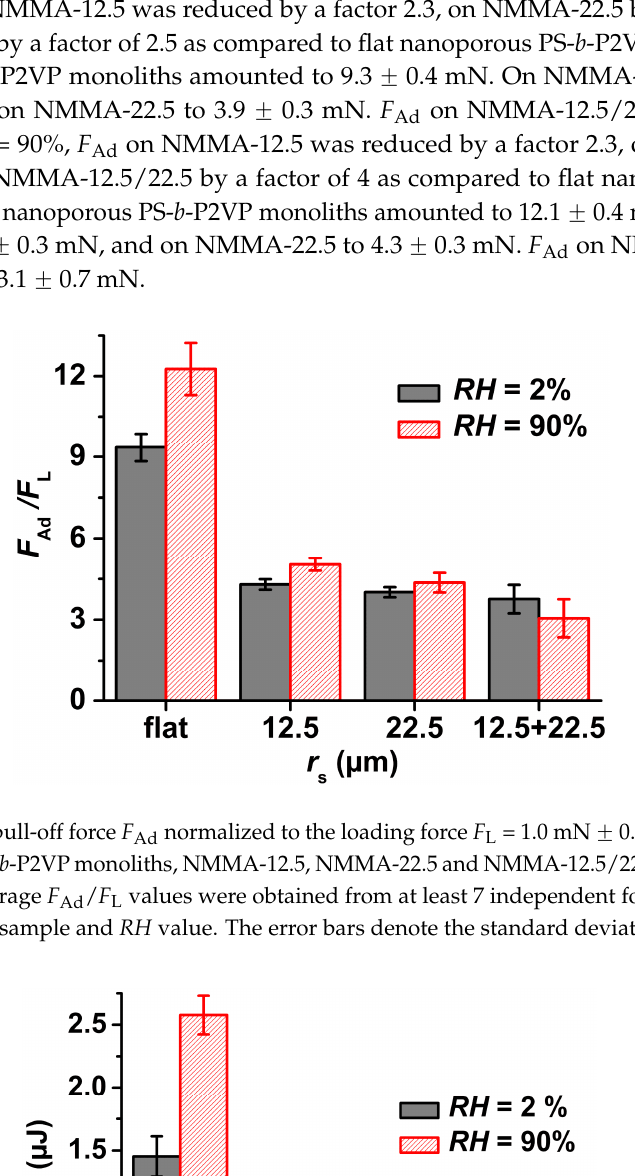
Figure 4. Retraction parts of force-displacement curves obtained on a flat nanoporous PS- b -P2VP monolith at RH = 2% (black curve) and at RH = 90% (red curve). Retraction started immediately after a pre-set loading force F L of 1 mN ± 0.1 mN had been reached.